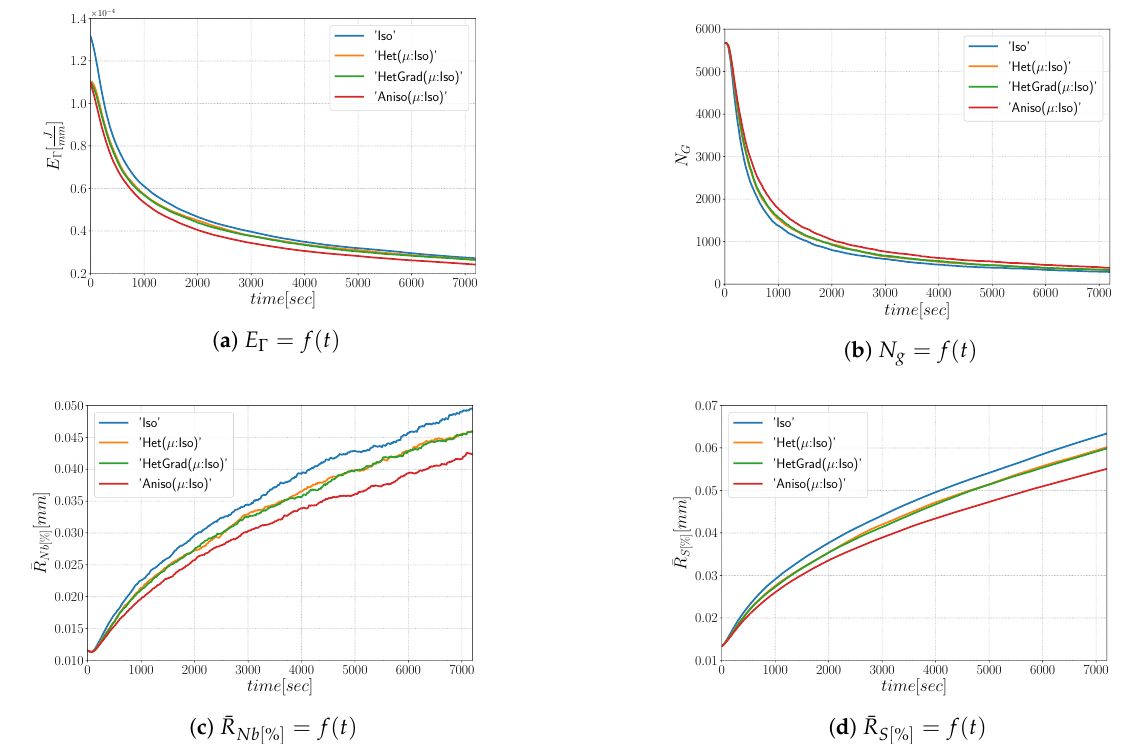
Figure A7. Time evolution for the different formulations: ( a ) the total GB energy, ( b ) the number of grains, ( c ) the mean radius weighted by number, and ( d ) the mean radius weighted by surface.